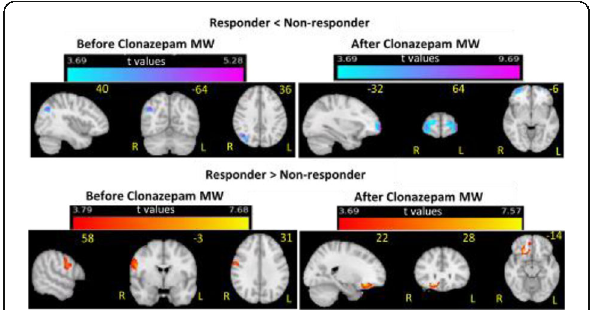
Fig. 1 (abstract P41). Differences in functional connectivity (FC) between the responder and the non-responder groups of BMS patients at before and after clonazepam mouthwash